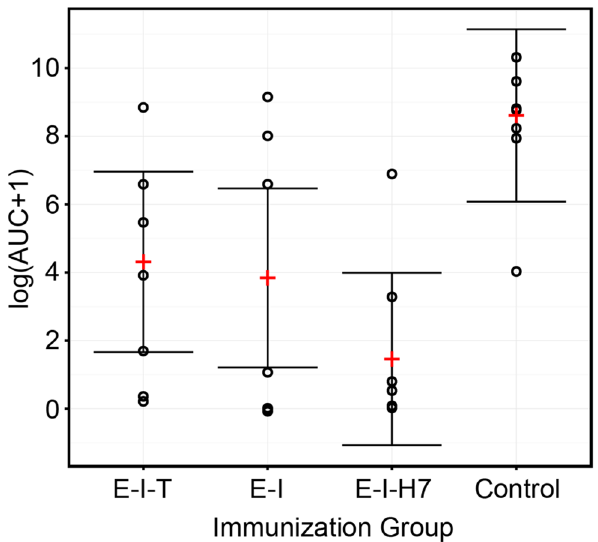
Fig 1. Total shedding of E . coli O157:H7 following oral challenge of immunized calves. Four groups of calves were immunized intramuscularly with either EspA, intimin and Tir ( E-I-T ), EspA and intimin ( E-I ), EspA, intimin and H7 flagellin ( E-I-H7 ) or adjuvant alone (Control) and subsequently orally challenged with E . coli O157:H7. Faecal bacterial shedding was monitored for 23 days post-challenge and the area under the bacterial shedding curve (AUC) was calculated over the total challenge period for each calf to give an estimate of total bacterial shedding. The AUC data were subsequently transformed using natural logarithmic scale. The plot shows the observed AUC data (open circles) and the estimated mean (plus) and 95% confidence interval (vertical lines) for each immunization group obtained from the linear mixed model fitted to the AUC